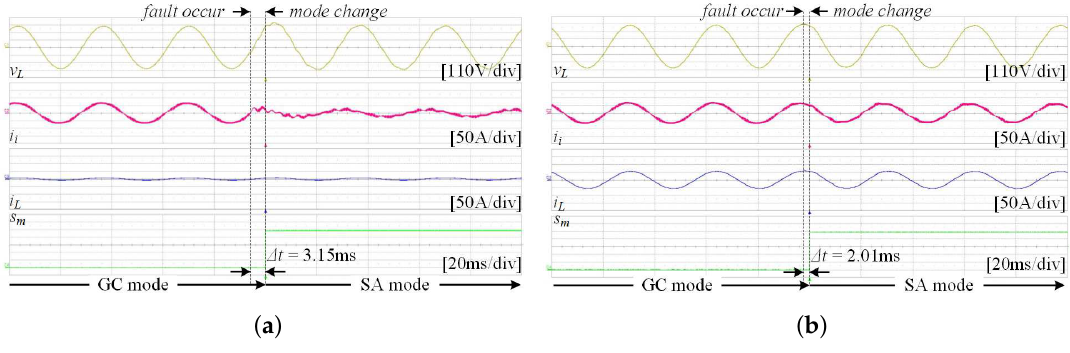
Figure 14. Experimental results of 30 kW PCS power with ( a ) 1 kW load ( b ) 30 kW load from grid-connected to stand-alone